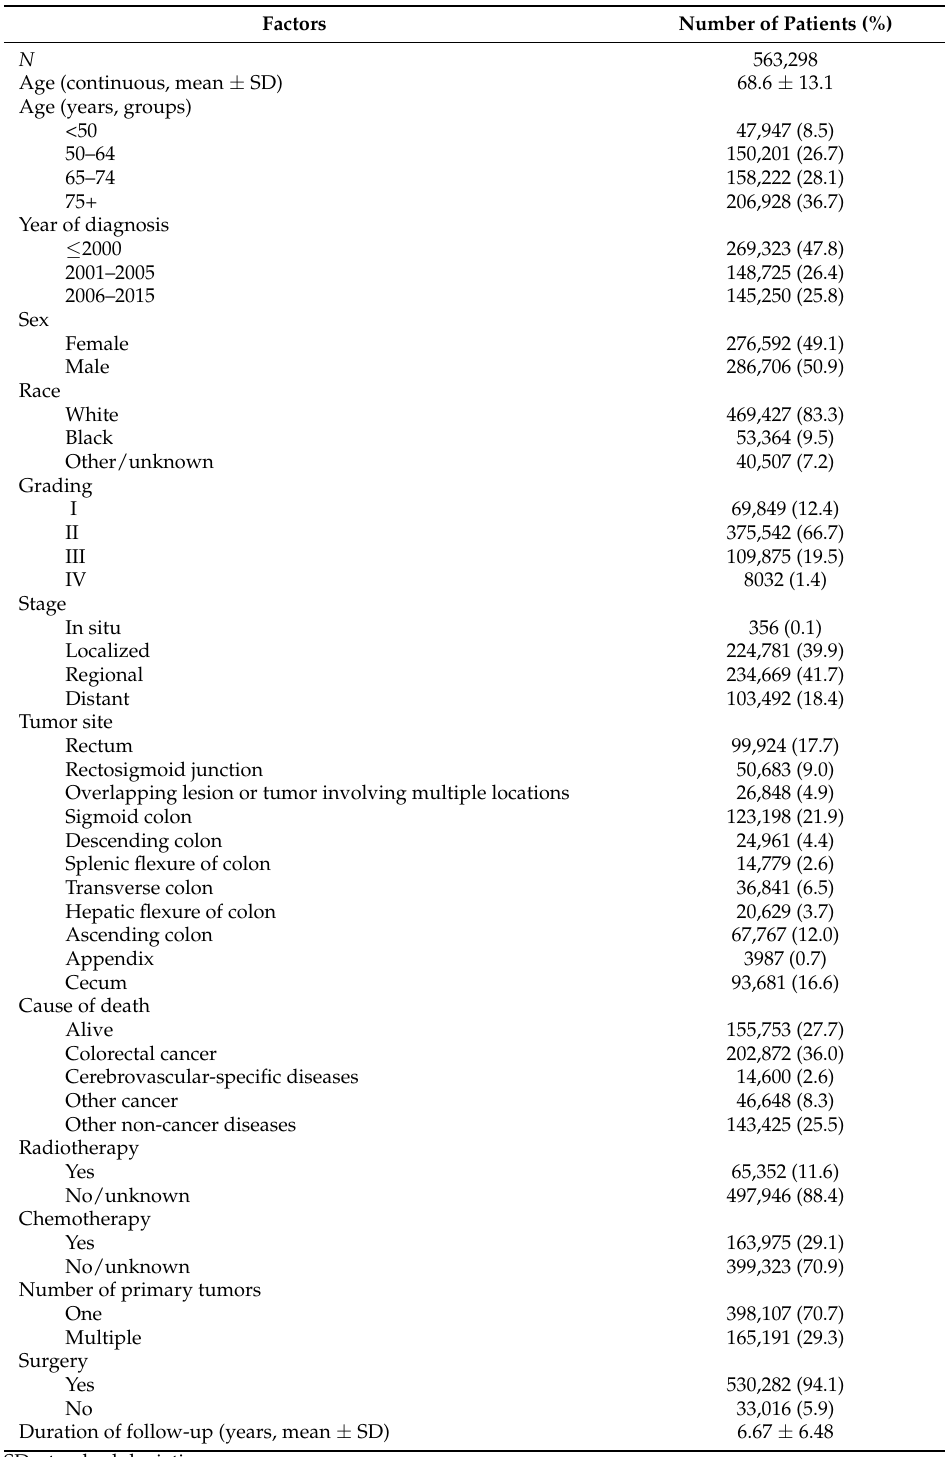
Table 1. Basic characteristics of included patients with colorectal cancer at time of